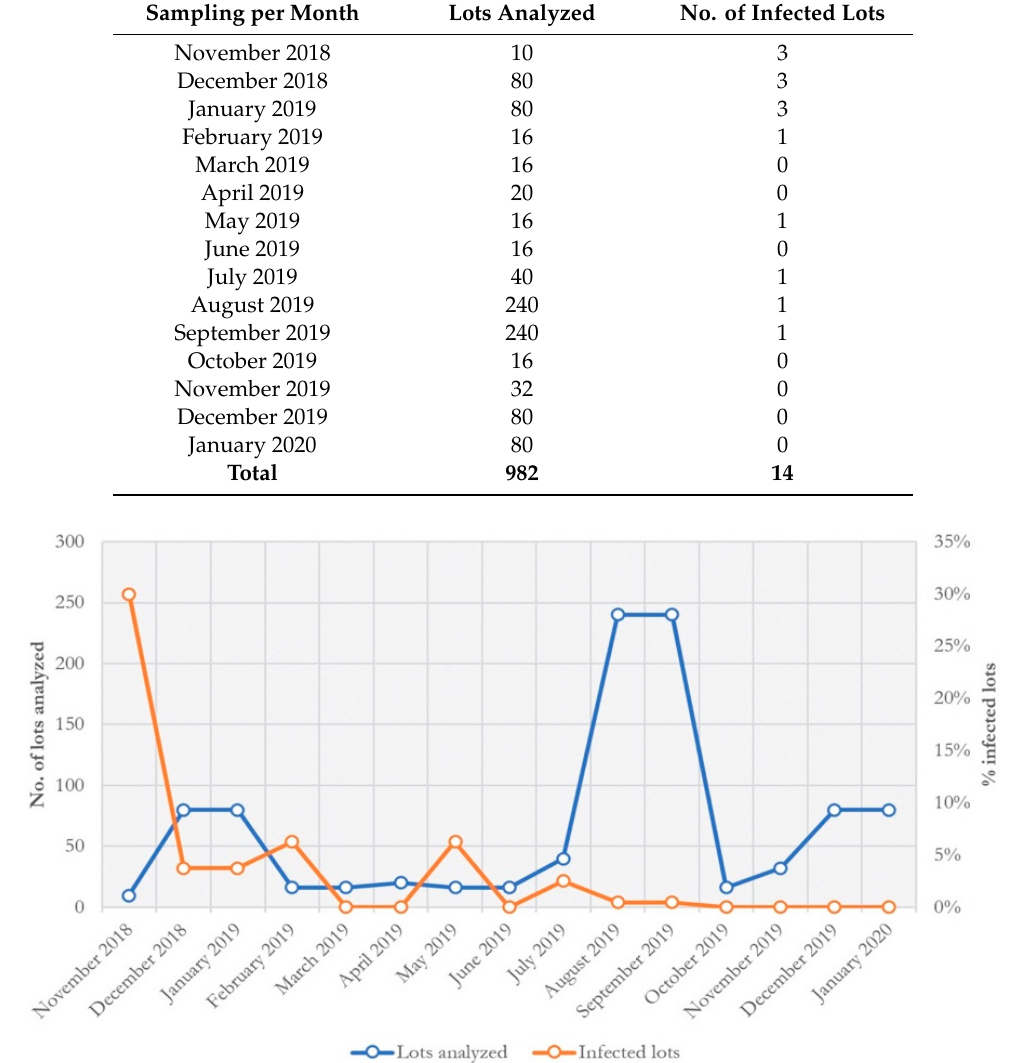
Figure 2. Number of lots of tomato plantlets analyzed per month, during the period November 2018–January 2020 and percentage of ToBRFV-infected